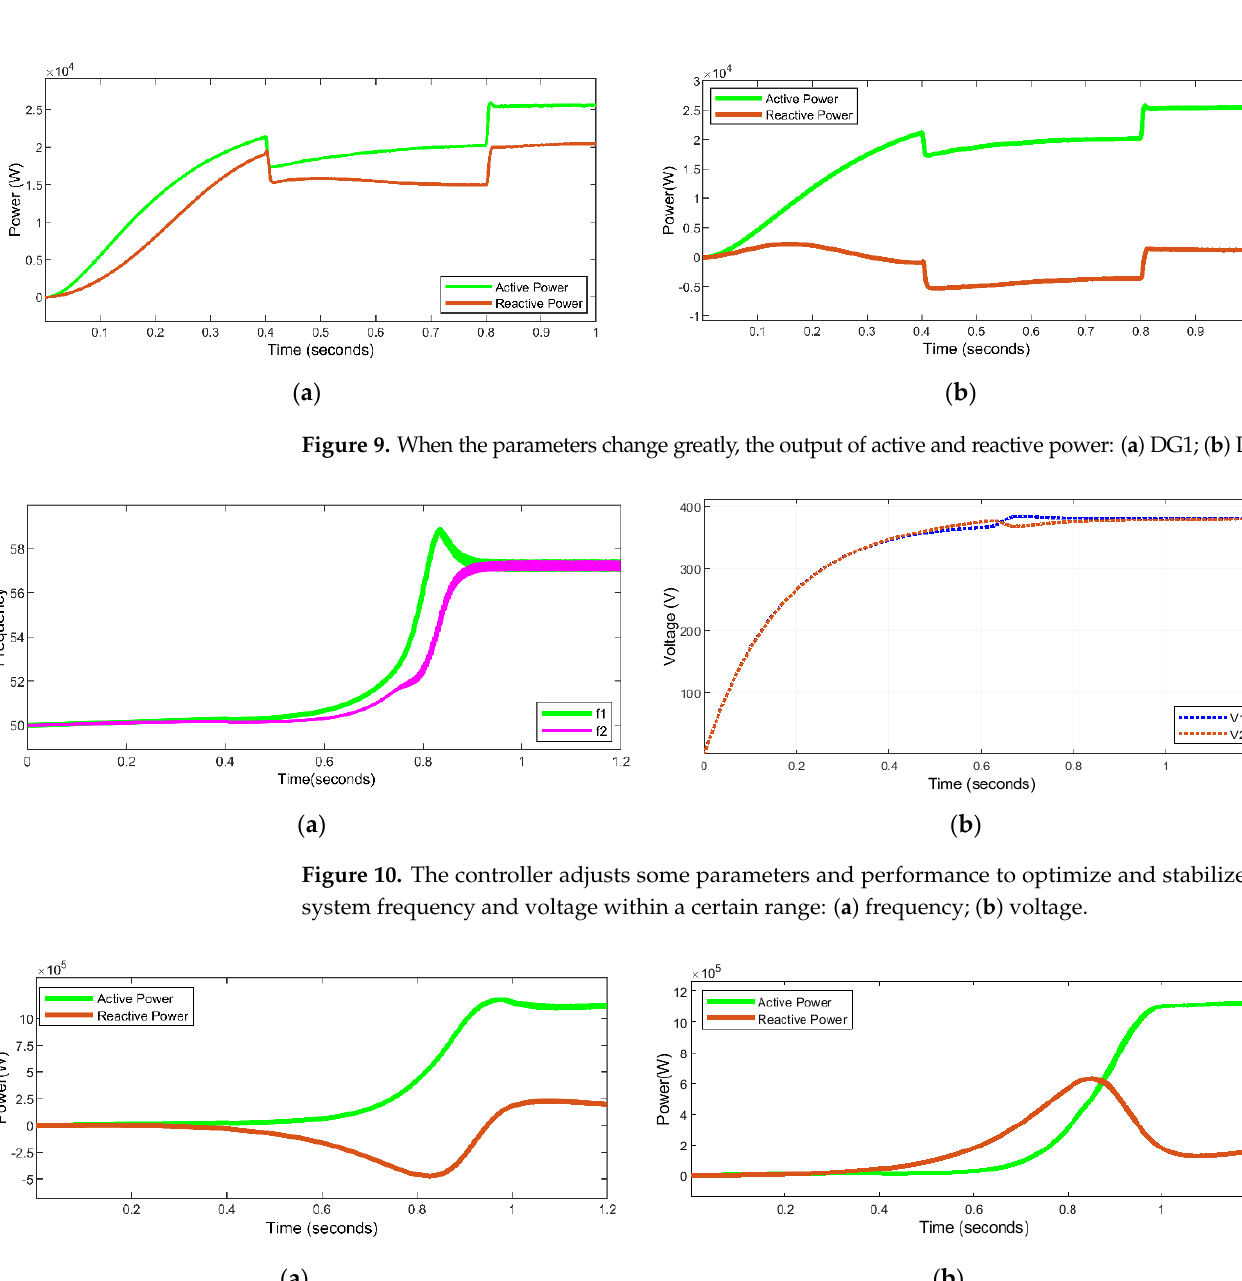
Figure 8. When the parameters change slightly, the output of active and reactive power: ( a ) DG1;